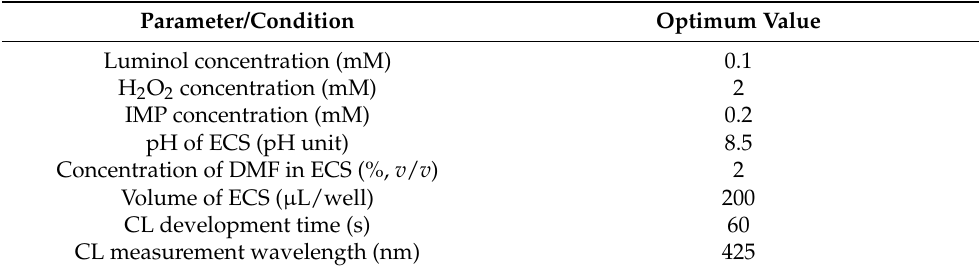
Table 4. Results linear regression analysis and validation parameters of the proposed CLEIA for BEV. Table 3. A summary for the optimization of the factors affecting the enhanced CL reaction used as detection system in the proposed CLEIA for BEV.